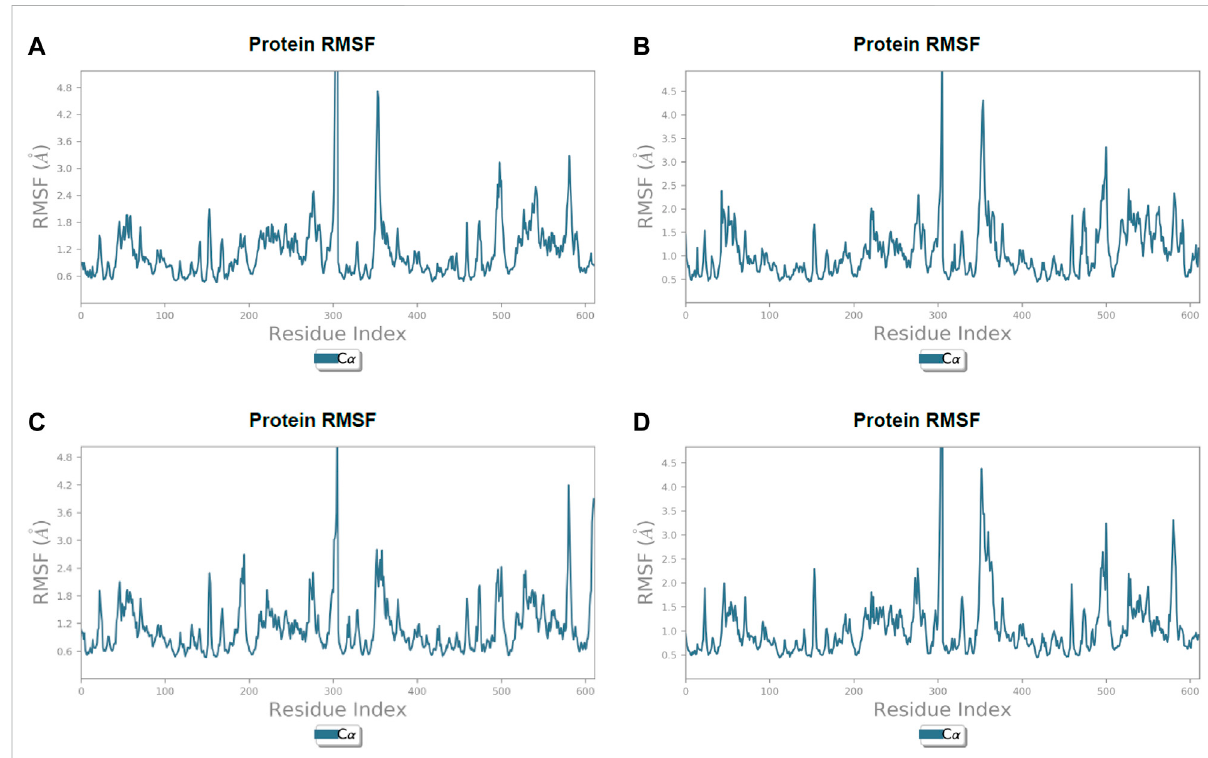
FIGURE 6 Linerepresentationoftheevolutionofroot-mean-square fl uctuationof3CLproteaseC α duringthe100 nsMDsimulation. (A)